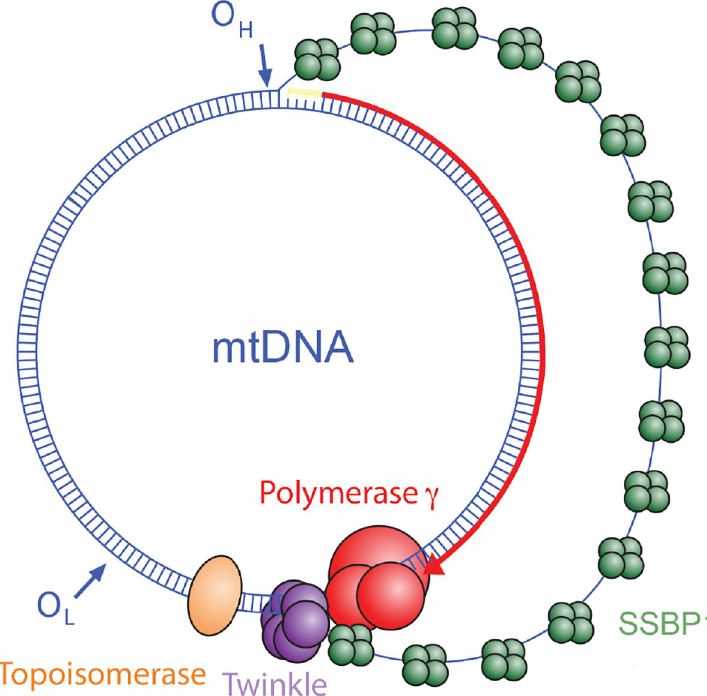
Fig 1. A schematic diagram of a mitochondrial DNA replication intermediate. Core replication proteins are illustrated: DNA polymerase γ ( red ), the Twinkle helicase ( purple ), mitochondrial single-stranded DNA binding protein, SSBP1 ( green ) and topoisomerase ( orange ). Image was adapted from [10] and updated based on recent findings [11].